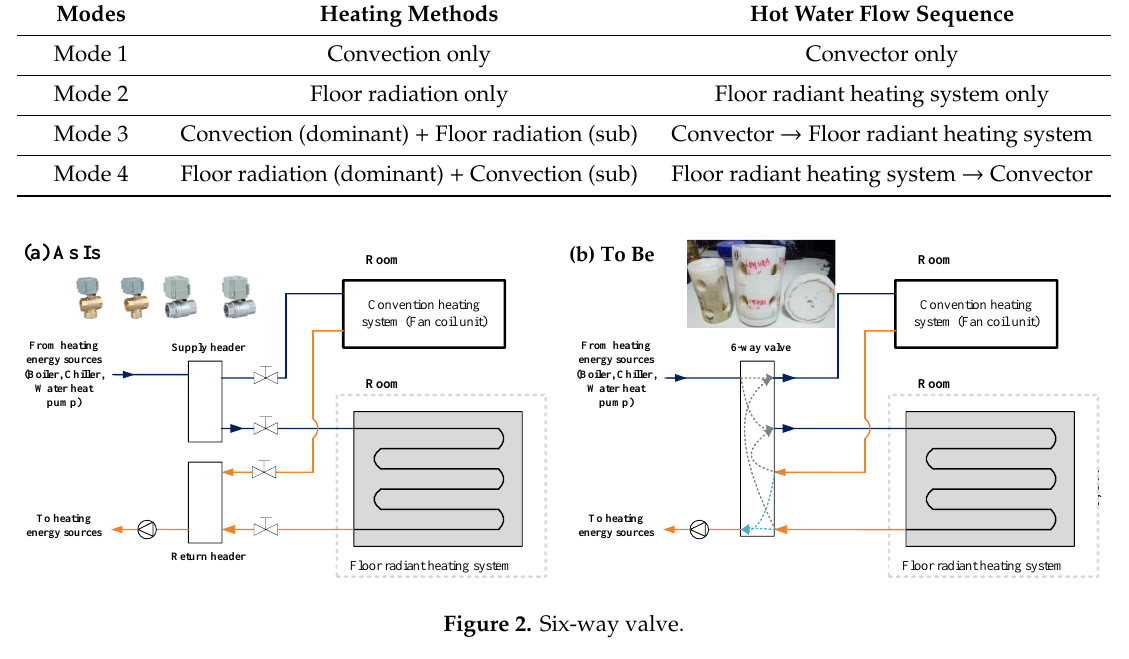
Figure 2. Six-way valve. Table 1. System operation modes.